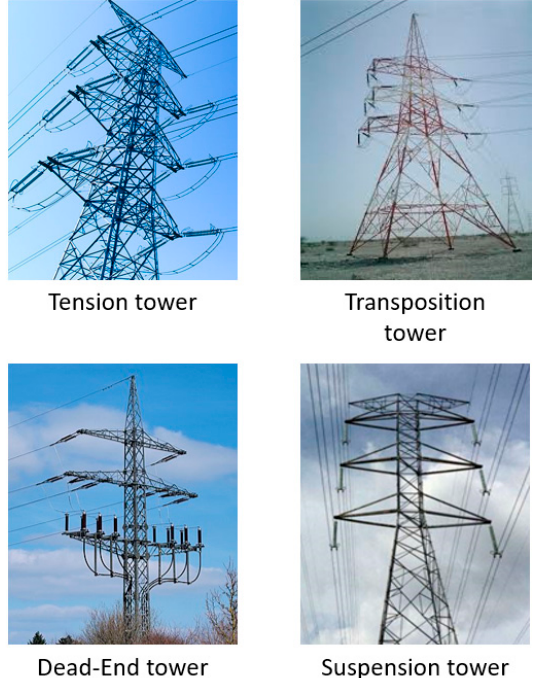
Figure 1. Types of latticed transmission tower [49,50].